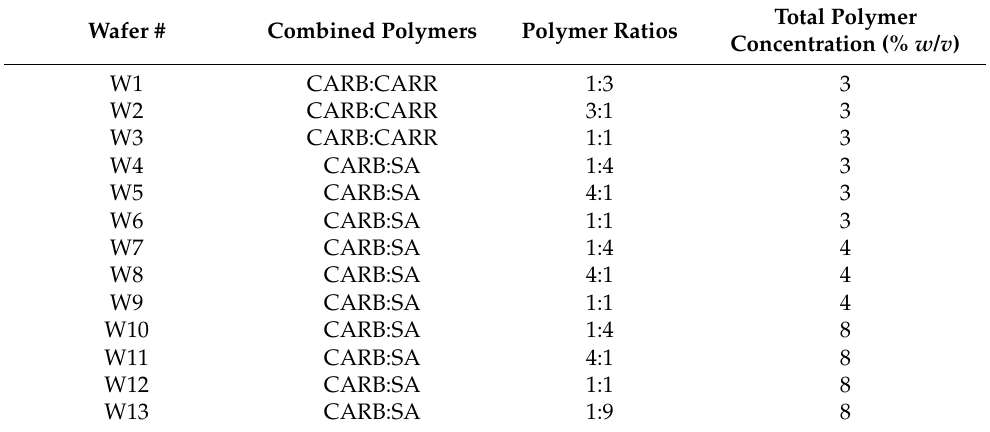
Table 1. Blank (BLK) composite CARB:CARR and CARB:SA gels showing the different ratios of the polymers and total polymer concentrations.